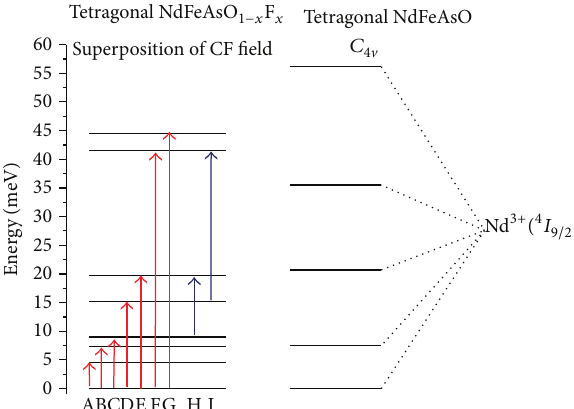
Figure 3: The Nd 3+ CF energy level schemes for both NdFeAsO and NdFeAsO 0.85 F 0.15 are shown. The values of energies of Nd 3+ in NdFeAsO 0.85 F 0.15 are sorted in increasing order: 0, 4.49, 7.34, 8.97, 15.17, 19.79, 41.50, and 44.51 meV. The energies of CF levels of NdFeAsO were obtained from another paper